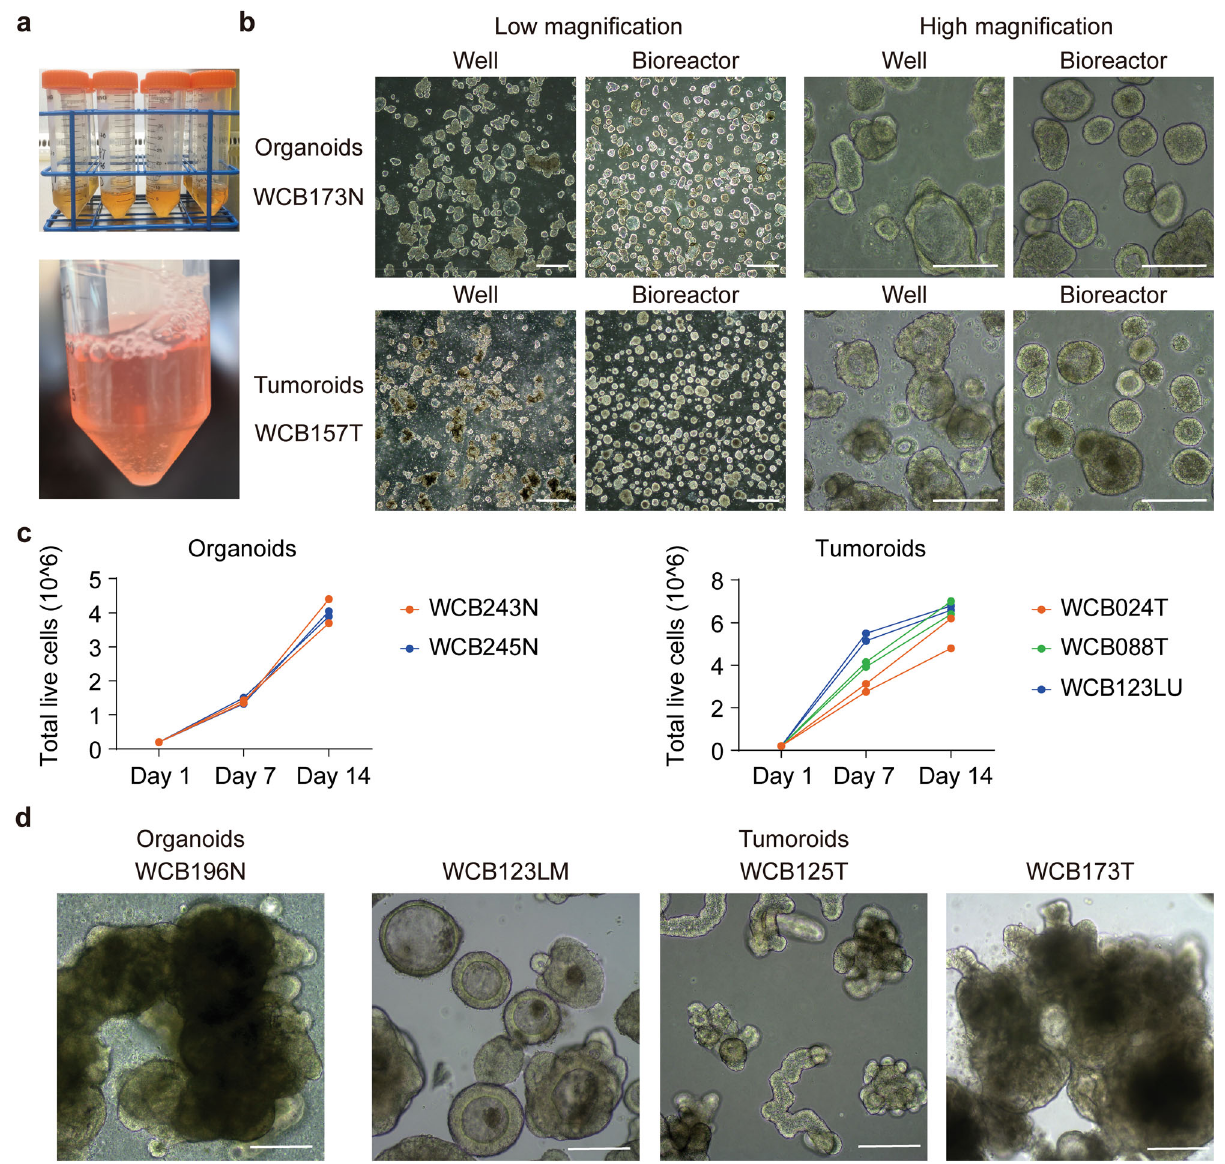
Fig. 7 Scalable expansion of colorectal organoids and tumoroids in bioreactor tubes. a Image of Corning ™ Mini Bioreactor Centrifuge Tubes used for culture expansion. b Representative images of organoids and tumoroids grown as LVM suspension cultures in 6-well plates or bioreactor tubes over a 14- day period; low-magni fi cation images, scale bars, 500 μ m; high-magni fi cation images, scale bars, 200 μ m. c Quanti fi cation of normal and cancer